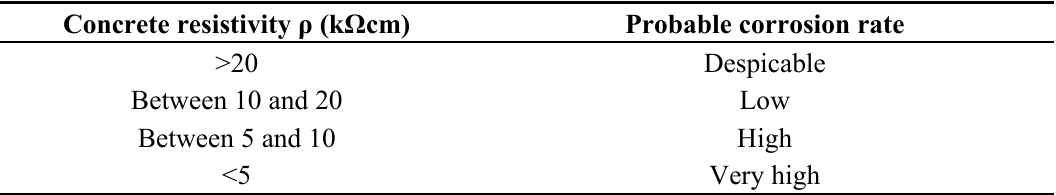
Table 2. Probability of corrosion as a function of the electrical resistivity CEB 192